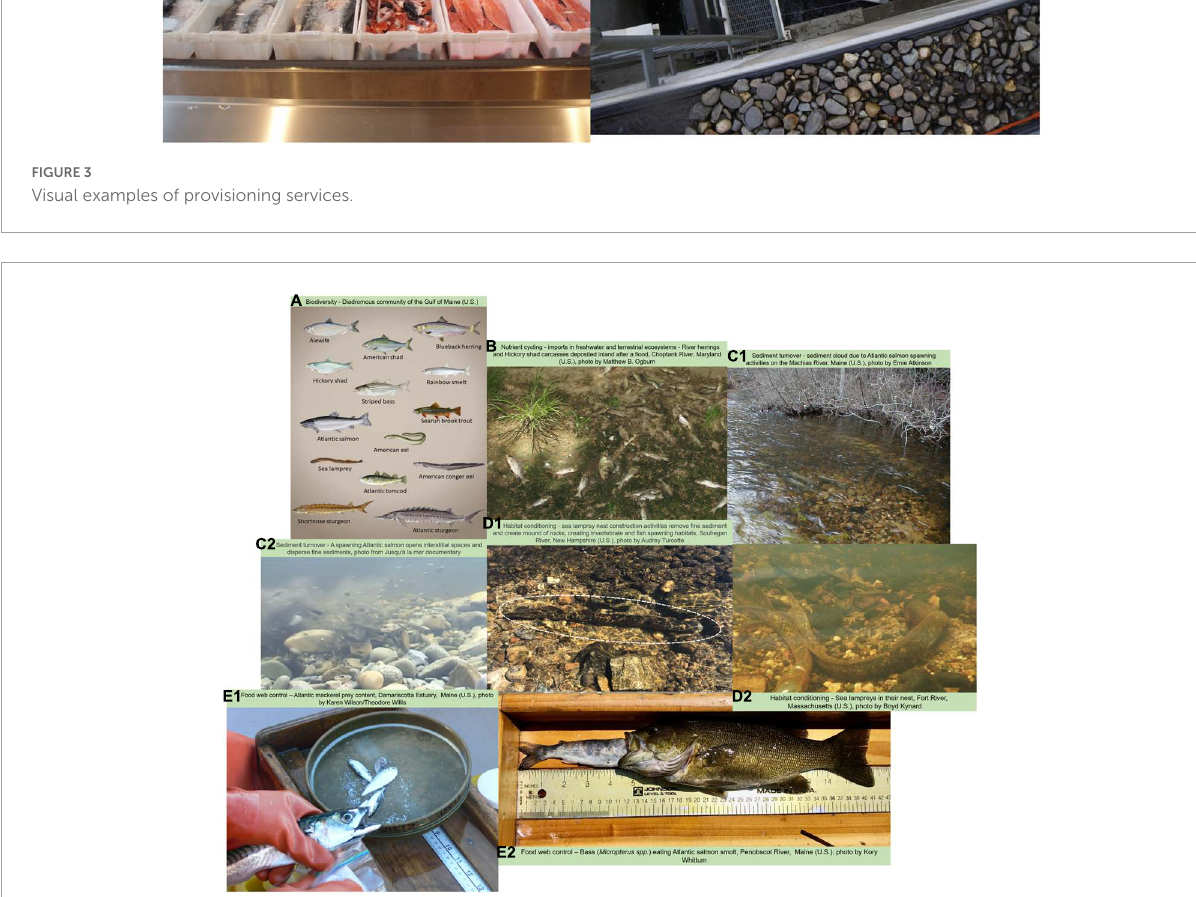
FIGURE4 Visual examples of regulating and maintaining